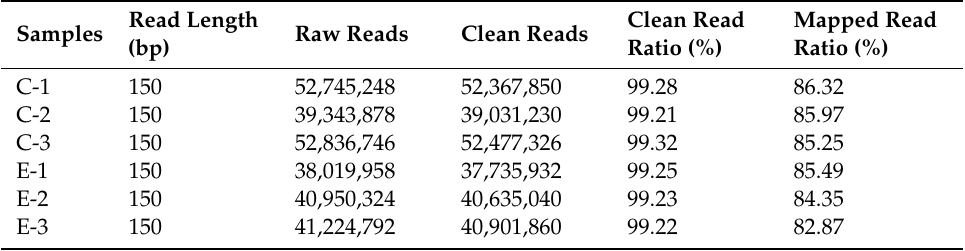
Table 1. Quality of RNA sequencing. C, control group; E, E. tarda -infected group. Each group was triplicated and shown as -1, -2, and -3.